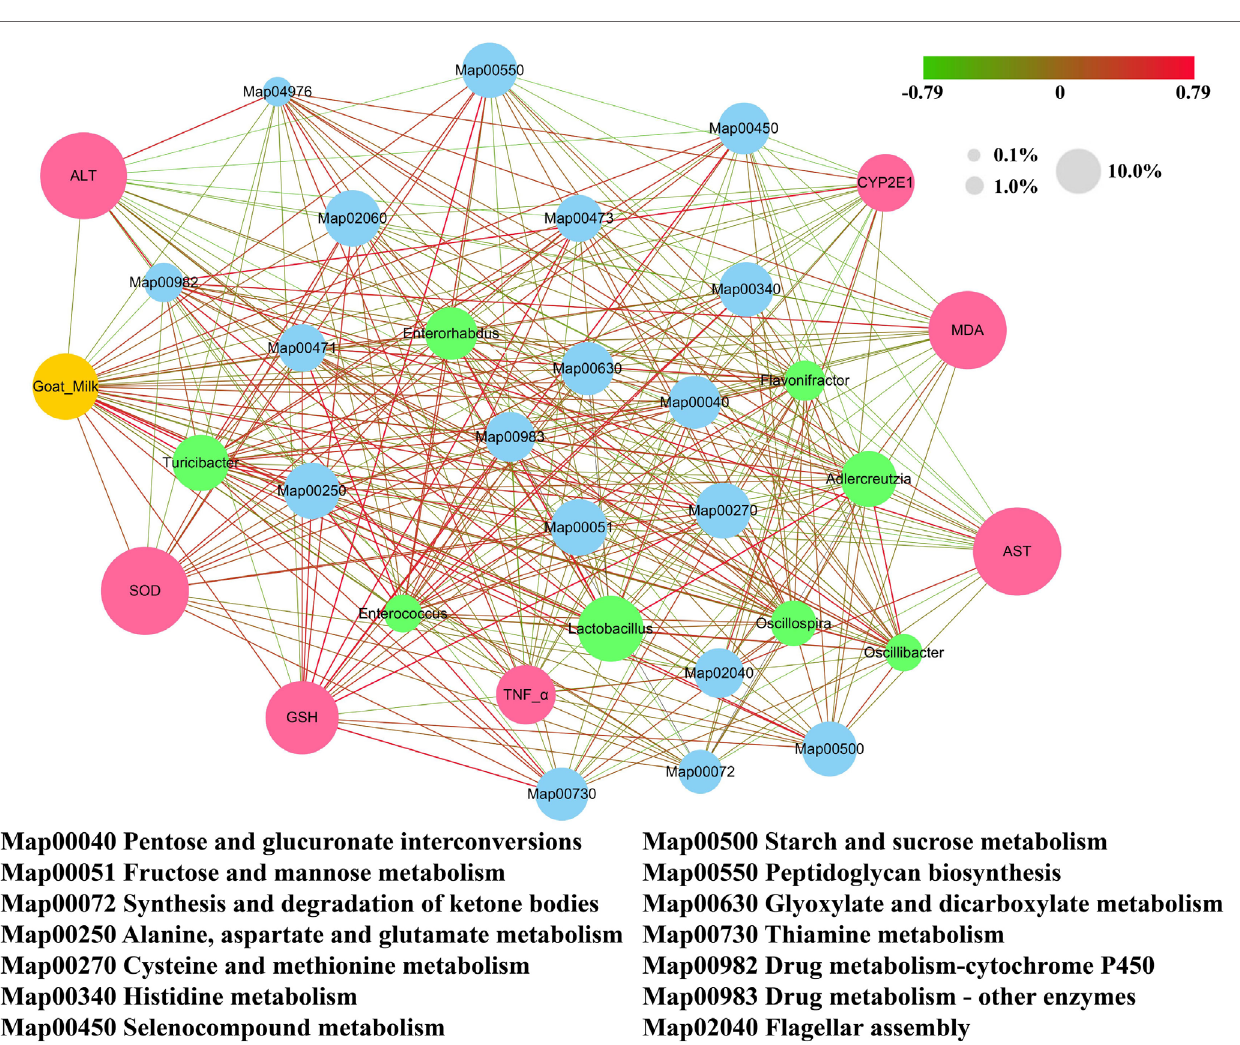
FigUre 7 | Correlation network established based on goats’ milk, bacterial genera that varied significantly in abundance, G group-enriched metabolisms, and the seven indicators of liver damage. Values of 0.1, 1.0, and 10.0% represent the relative abundance of the same category of elements (i.e., bacterial genera, metabolisms, and liver damage indicators) presented in the network. Positive correlations are connected by red lines ( R > 0), and negative correlations are connected by gray lines ( R < 0). The gradually changing color presented in the figure illustrates the degree of the